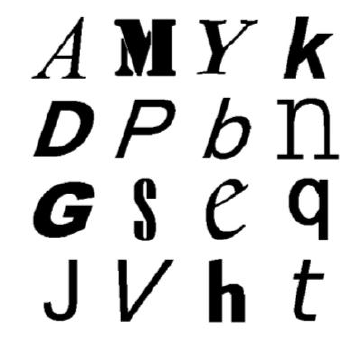
Fig. 1. Some samples of the characters dataset